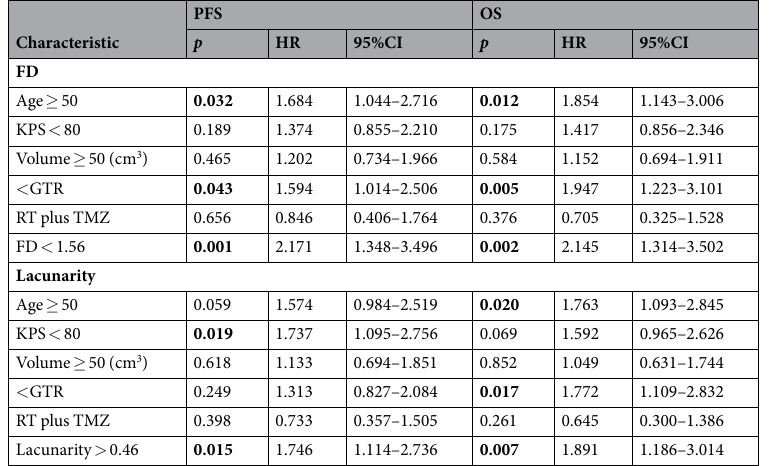
Table 3. Multivariate Cox analysis for factors potentially influence survival outcomes (FD, lacunarity separately).